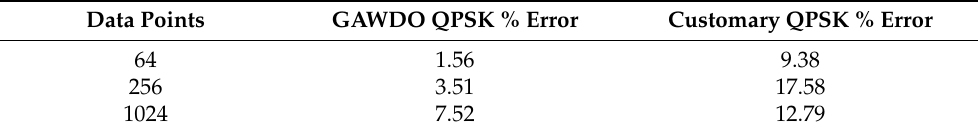
Table 5. BER comparison between GAWDO and customary QPSK in a noisy OFDM